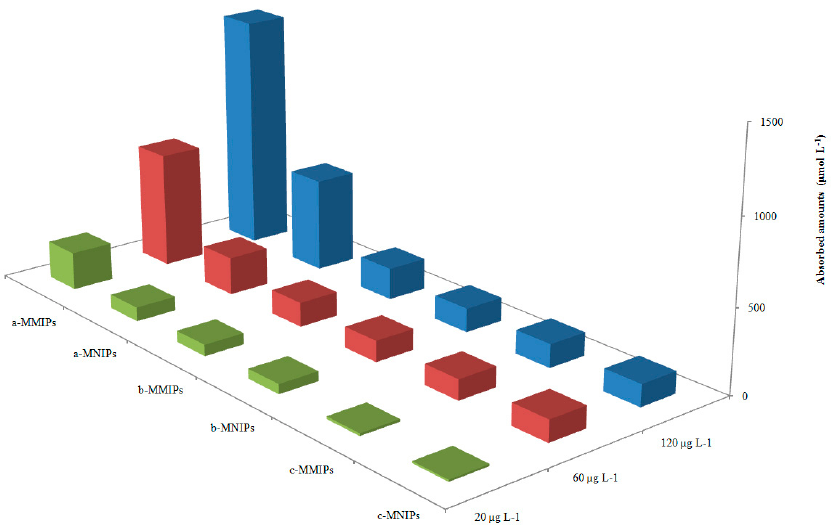
Figure 6. Selective recognition capability of MMIPs and MNIPs to (a) 4-MEI, (b) salicylic acid, and (c) benzoic acid at concentrations of 20, 60 and 120 mg L − 1 . benzoic acid at concentrations of 20, 60 and 120 mg L − 1 . Table 2. Recognition properties of MMIPs and MNIPs a . Table 2. Recognition properties of MMIPs and MNIPs a